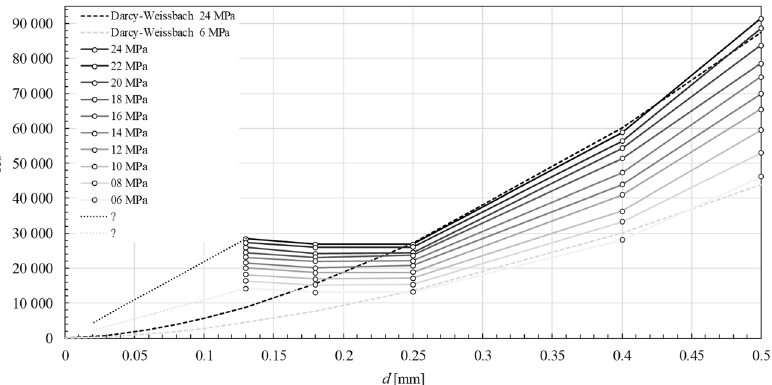
Figure 5. Experimental points ◦ of dependence of the Reynolds number Re in metal tubes of length 20 mm on internal diameter d for input pressure p = (6, 8, 10, 12, 14, 16, 18, 20, 22, 24) MPa from values in Table 1. Above 0.25 mm in diameter, the experimental values for 6 MPa and 24 MPa are in good agreement with the theoretical prediction of the Darcy–Weissbach equation with Von Karman–Nikuradse loss coefficient (dashed lines). In possible extrapolation below 0.13 mm, we can guess the flow rate has already reached a constant theoretical maximum and the Reynolds number would only be a linear function of the diameter d (dotted